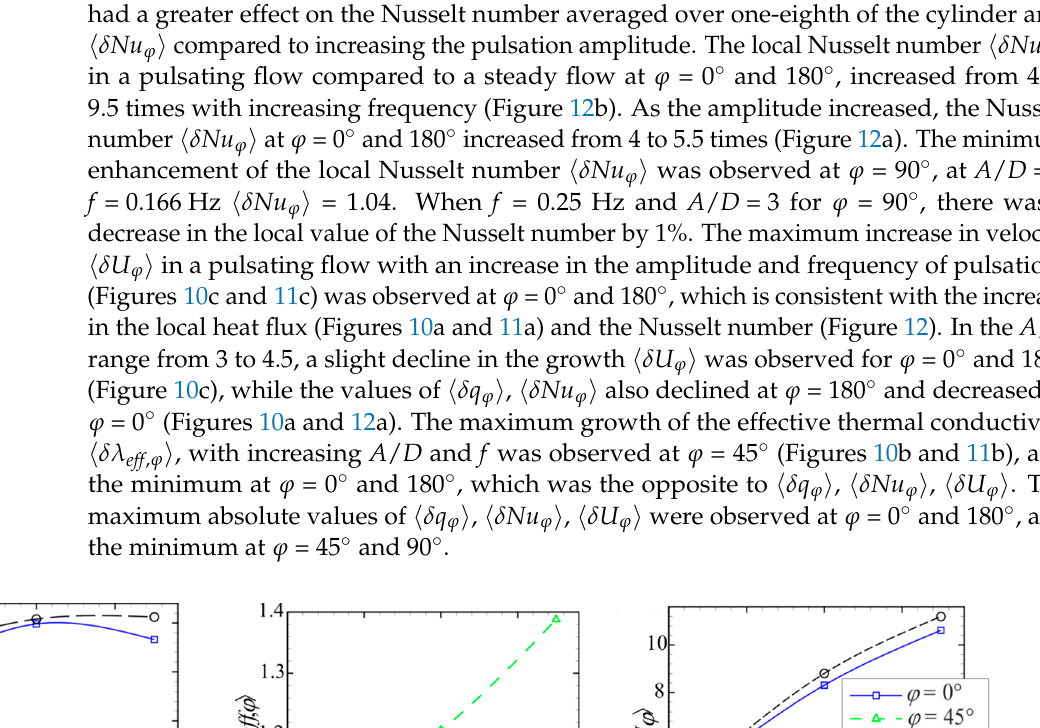
13 of 24 Figure 9. The effect of pulsations on instantaneous flow and heat transfer characteristics averaged over space at f = 0.5 Hz for one period of pulsation. ( a ) Variation of heat flux ratio δ q o = q o , p / q o , st with τ / T . ( b ) Variation of effective thermal conductivity ratio δλ eff , a = λ eff , a , p / λ eff , a , st with τ / T ;.( c ) Variation of velocity ratio δ U a = U a , p / U a , st with τ / T . ( d ) Variation of temperature difference ratio δ Δ t = Δ t p / Δ t st with